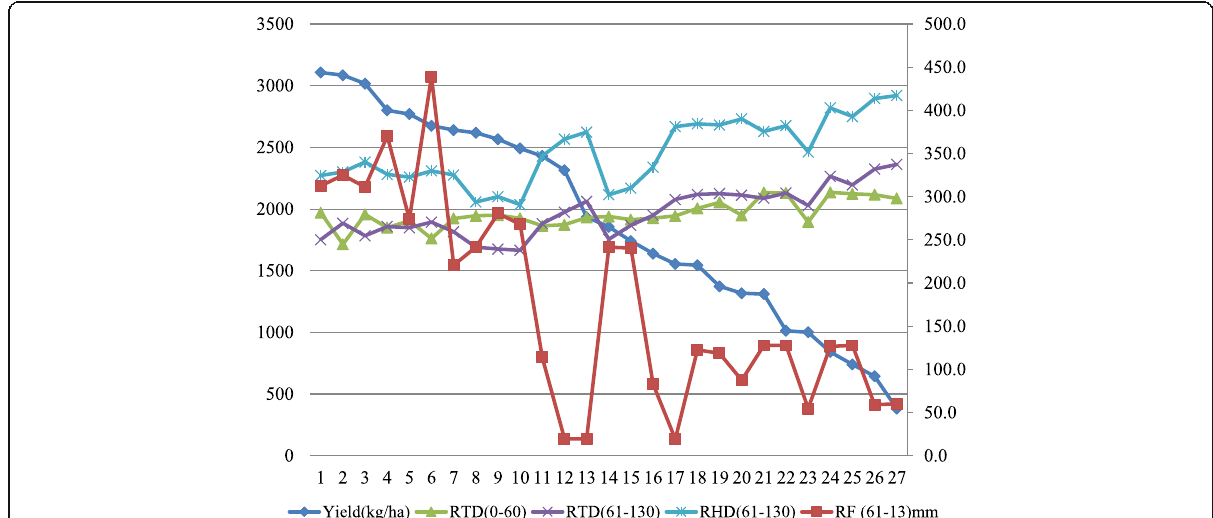
Fig. 2 Graphic representation of yield with weather parameters Table 6 Quality parameters as influenced by genotypes and dates of sowing Date of 2.5% span length ( mm) Uniformity ratio Micronaire sowing